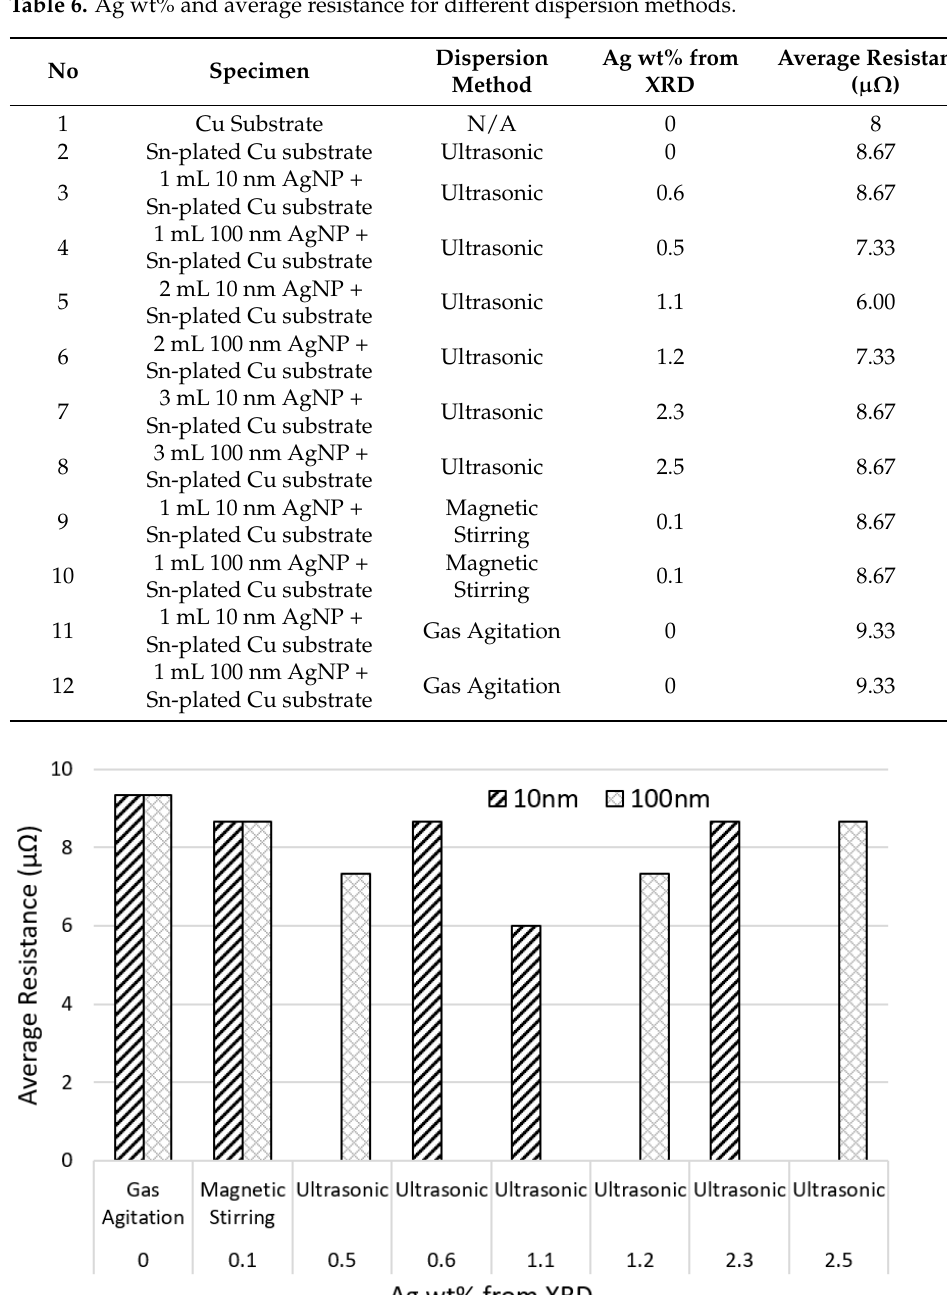
Figure 20. Average resistance vs the percentage of AgNP.